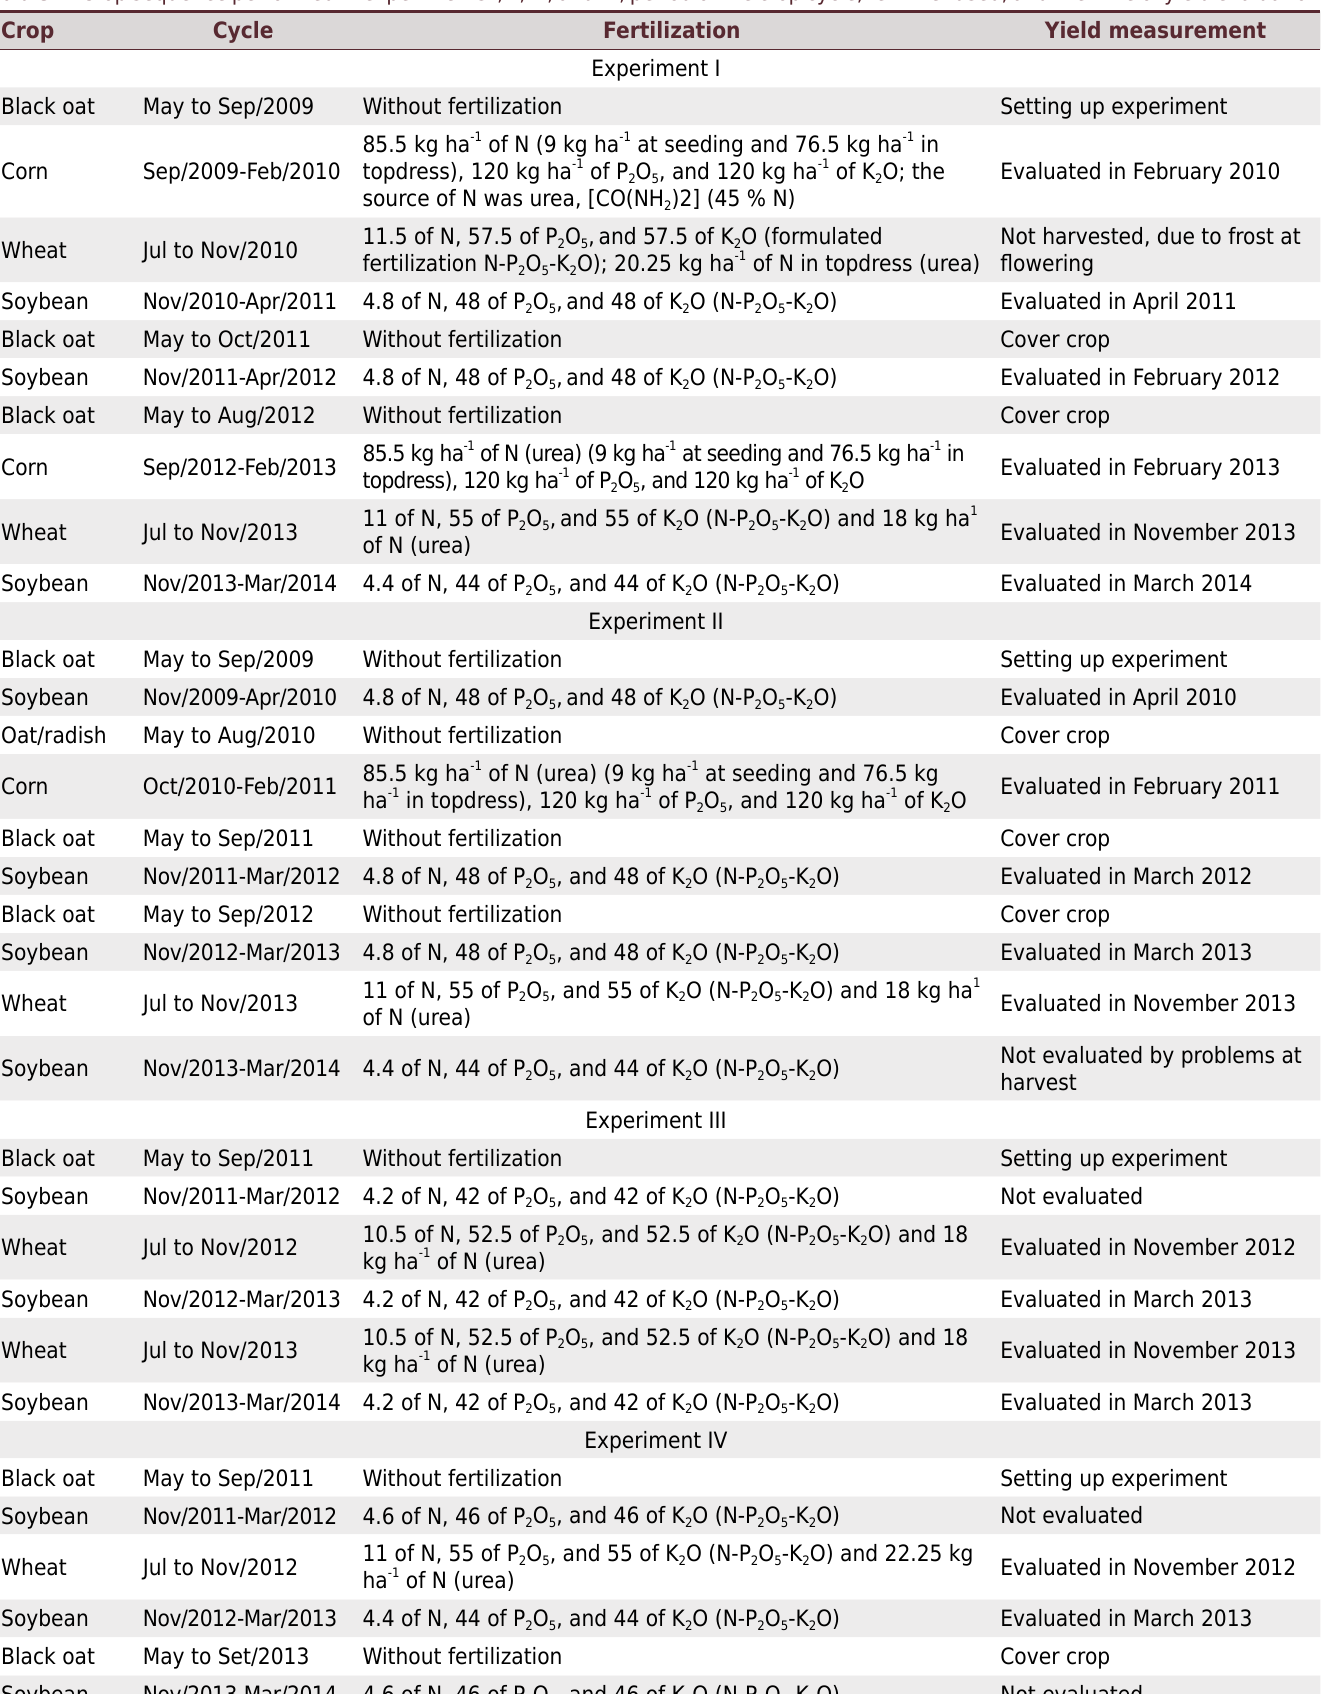
Table 2. Crop sequence performed in experiments I, II, III, and IV, period of the crop cycle, fertilizer used, and the time of yield evaluation Crop Cycle Fertilization Yield measurement Experiment I Black oat Without fertilization Setting up